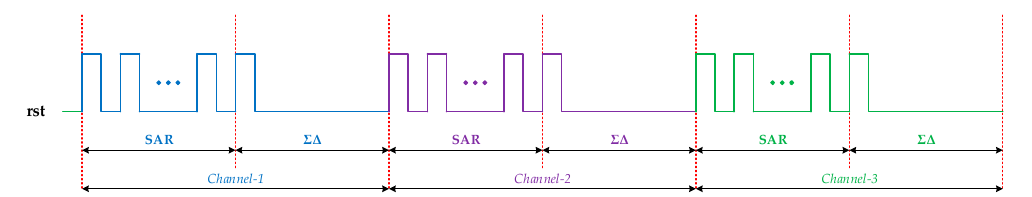
Figure 5. Timing diagram of incremental zoom ADC.